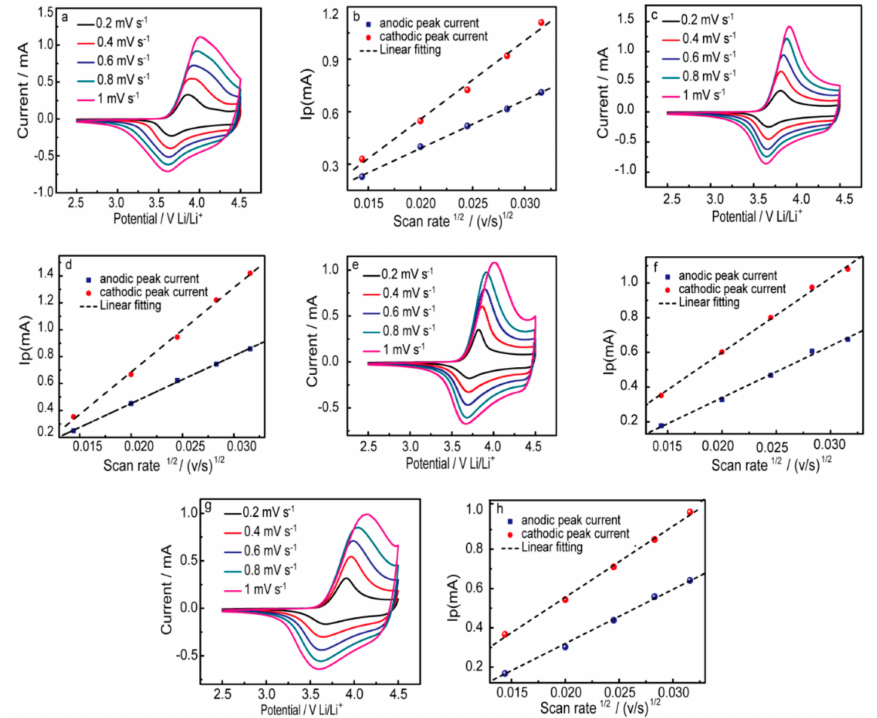
Figure 6. ( a , c , e , g ) CV curves of LNCM-0, LNCM-1, LNCM-2, LNCM-3 cathodes at a sweep rate of 0.2~1 mV s − 1 , ( b , d , f , h ) relationship between peak current Ip and square root of sweep speed (V 1 / 2 ) of LNCM-0, LNCM-1, LNCM-2, LNCM-3